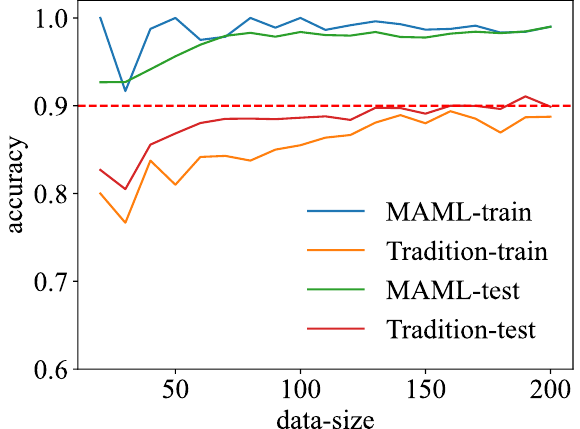
Figure 16. F1 score of MAML-ANN and traditional ANN.